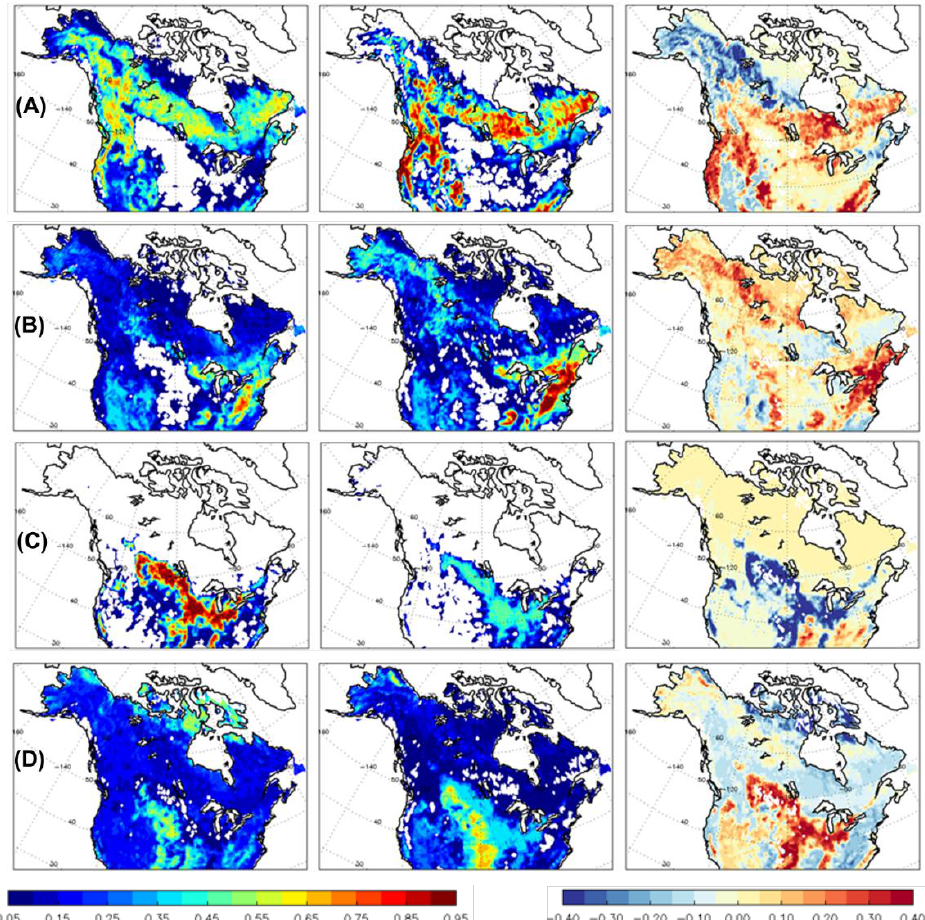
Figure 8. The fractional coverage of four CLASS PFTs from CCI (left), GLC2000 (middle), and the difference (GLC2000-CCI, right) for ( a ) needleleaf forest, ( b ) broadleaf forest, ( c ) crop, and ( d ) grass.